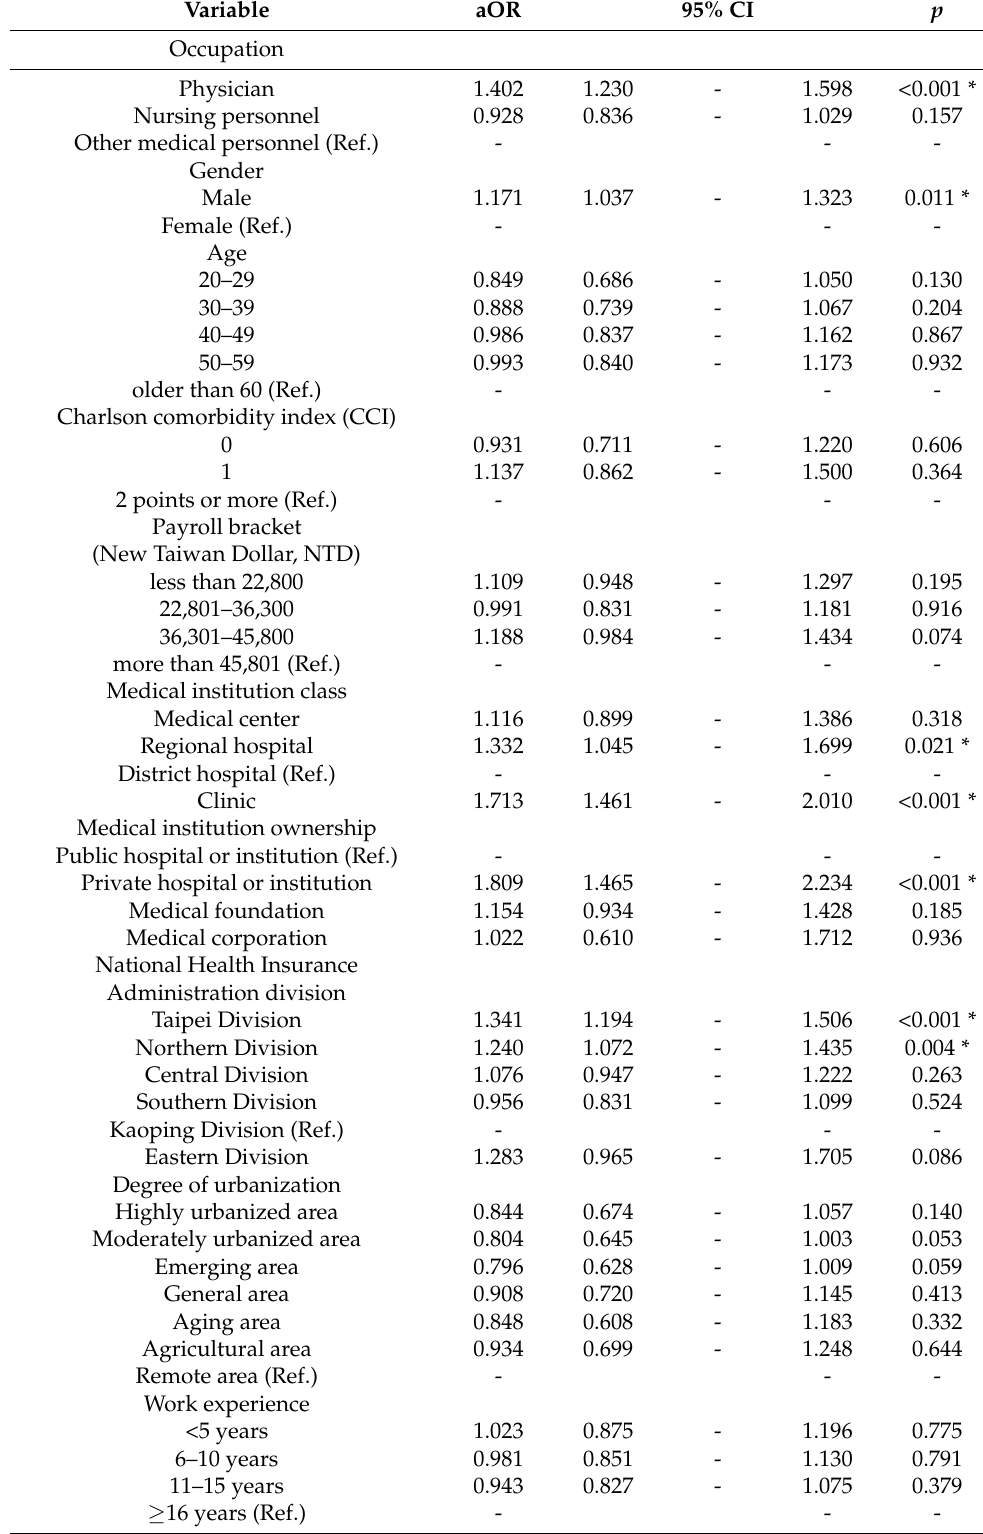
Table 5. Multivariable analysis of associations between medical providers and digestive diseases (N =